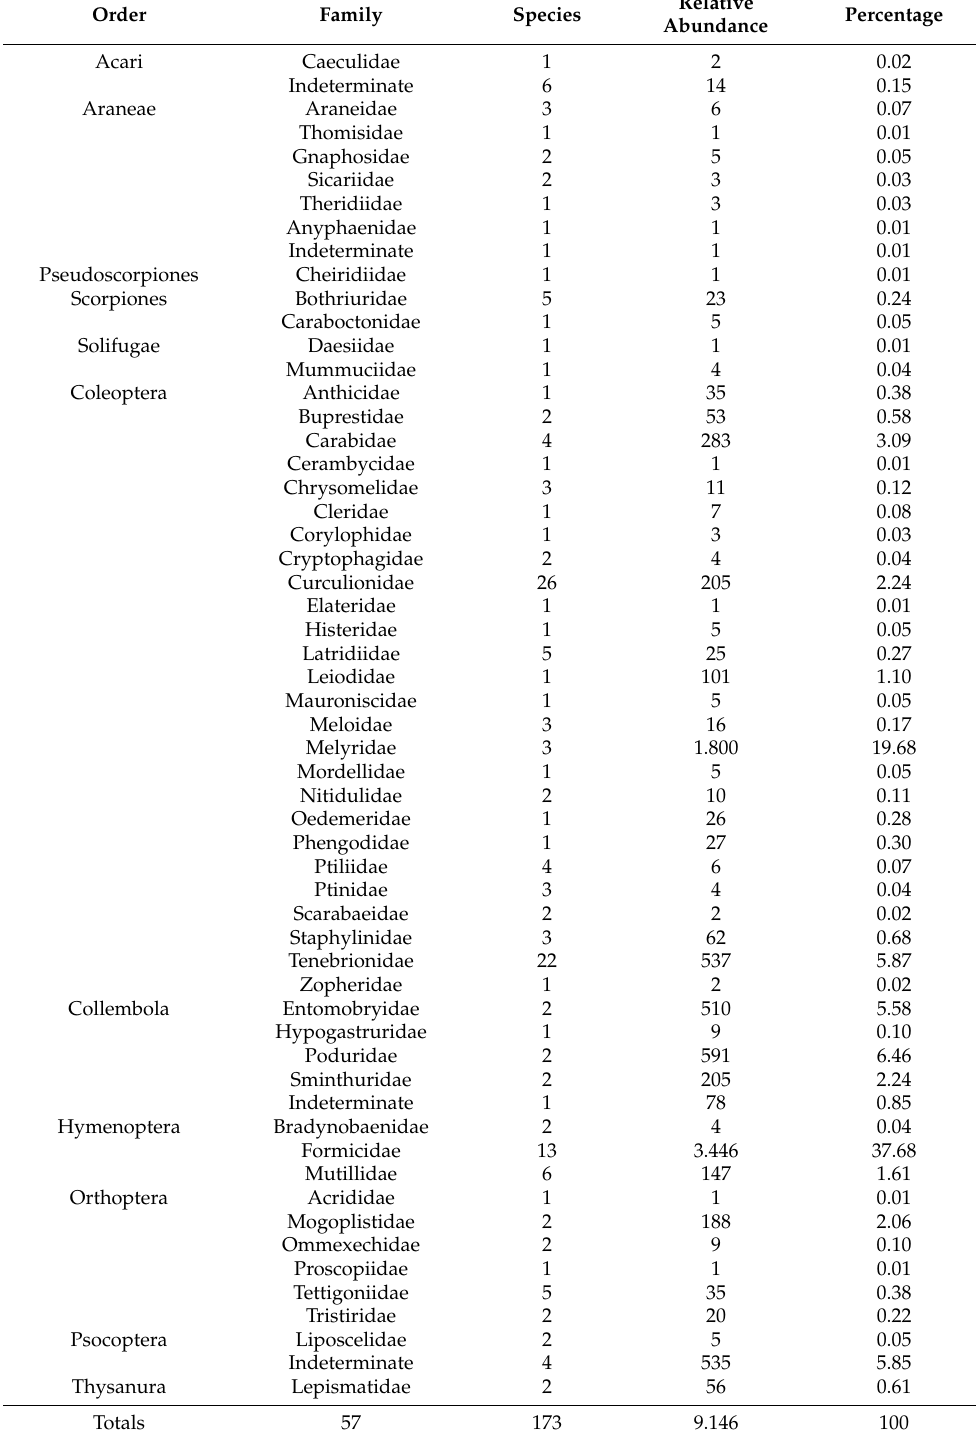
Table 3. Richness of species and relative abundance (individuals captured) for the different families of epigean arthropods registered in Paposo (Antofagasta Region, Chile). Order